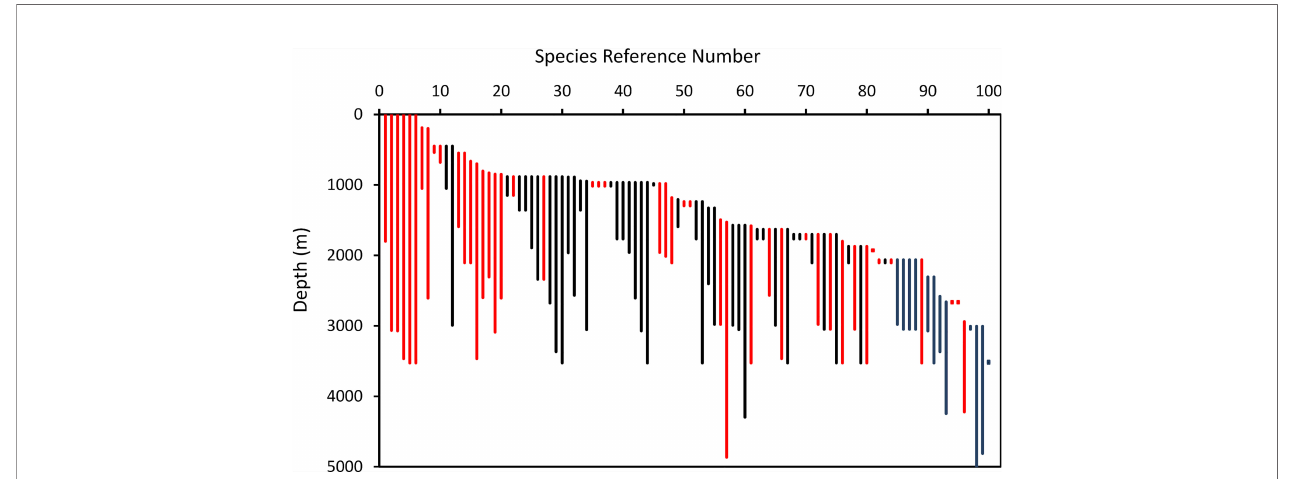
FIGURE 7 | Depth ranges of 100 species of demersal (black) and benthopelagic (red) fi shes on the North Mid- Atlantic Ridge, ranked in order of minimum depth of occurrence. (The key to species is in Table 3